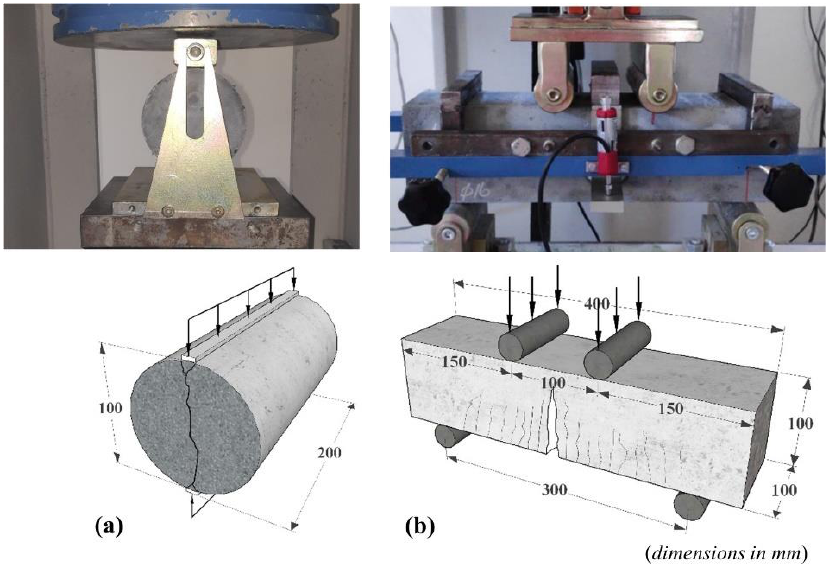
Figure 2. ( a ) Splitting tensile test setup, ( b ) Flexural test setup.